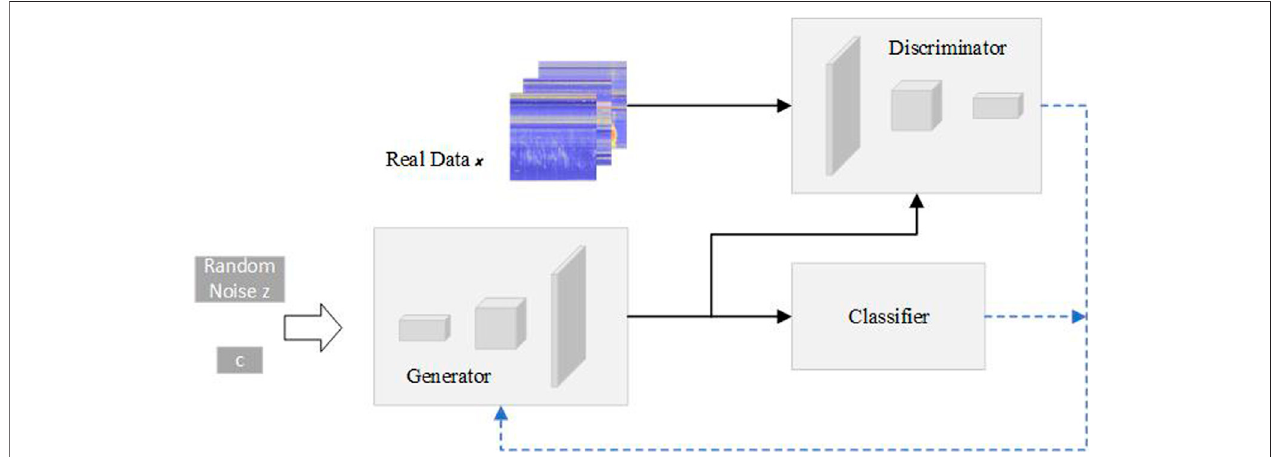
FIGURE 2 | Structure of the C-DCGAN model, including three major modules: the classi fi er, the discriminator (D), and the generator (G) (see text for details).